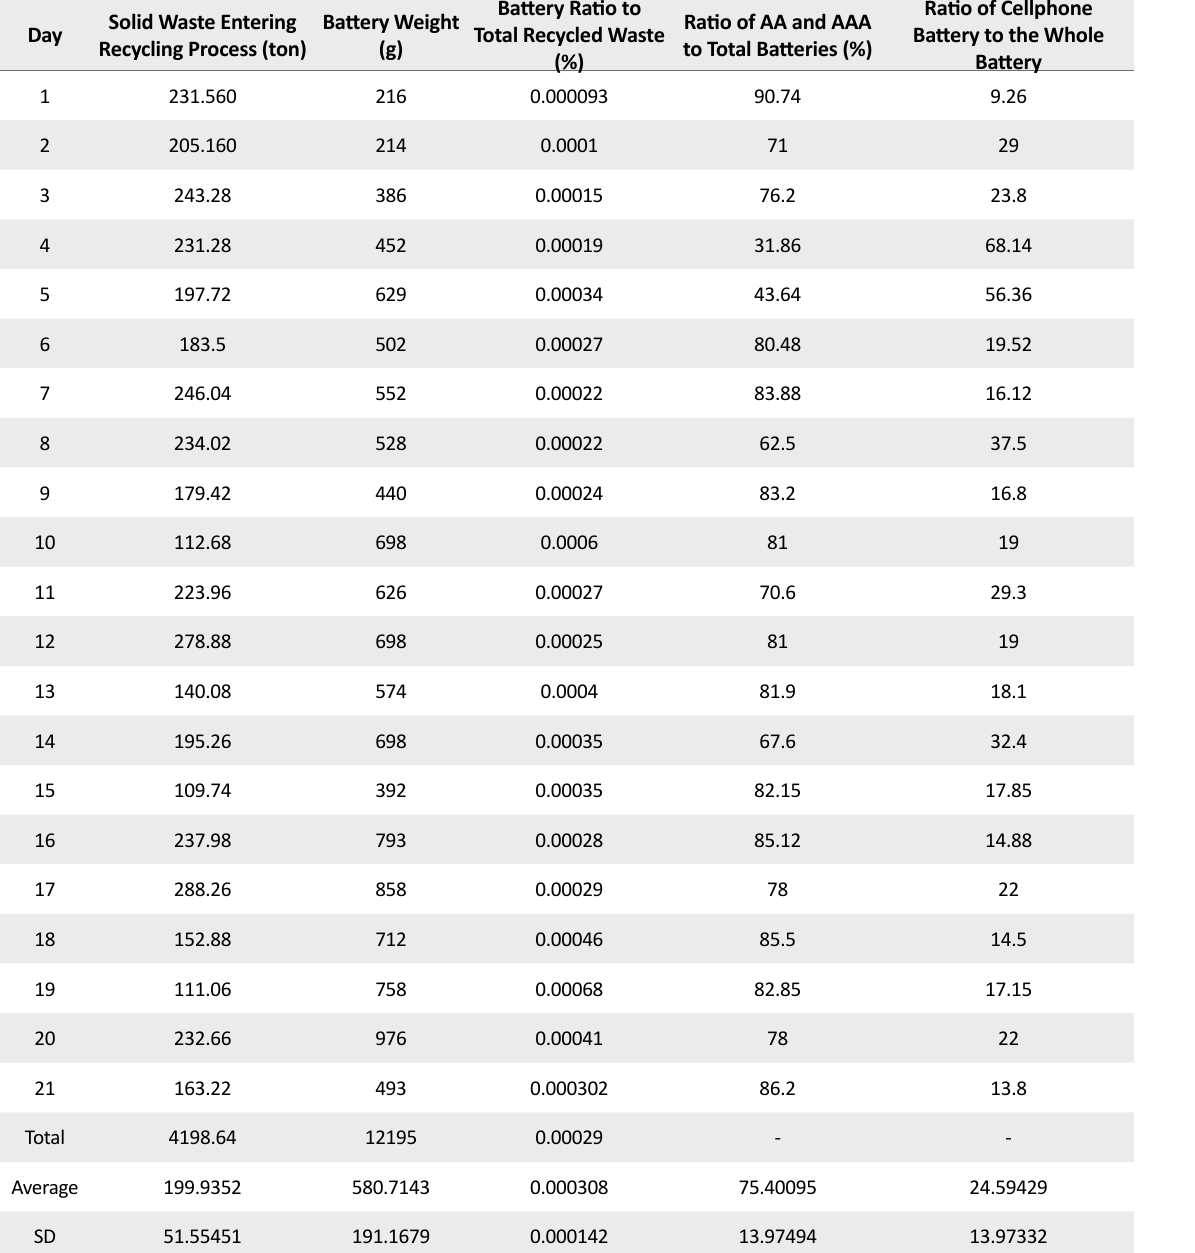
Table 6. Daily analysis of municipal waste at Tabriz landfill site